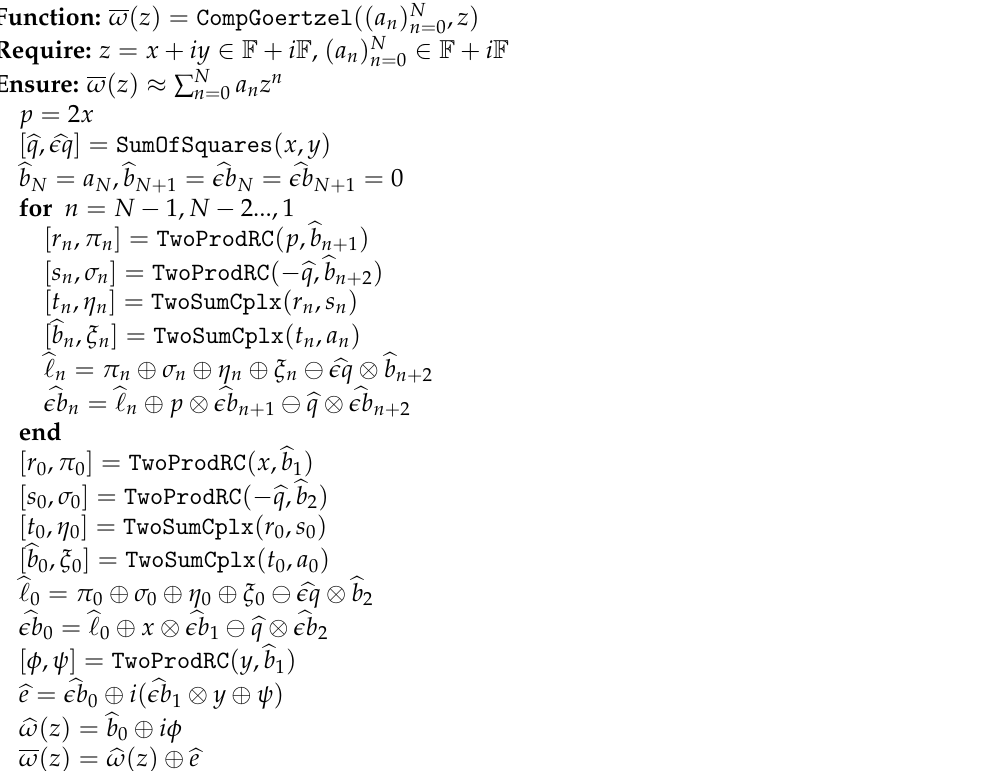
Algorithm 4 Polynomial evaluation by compensated Goertzel